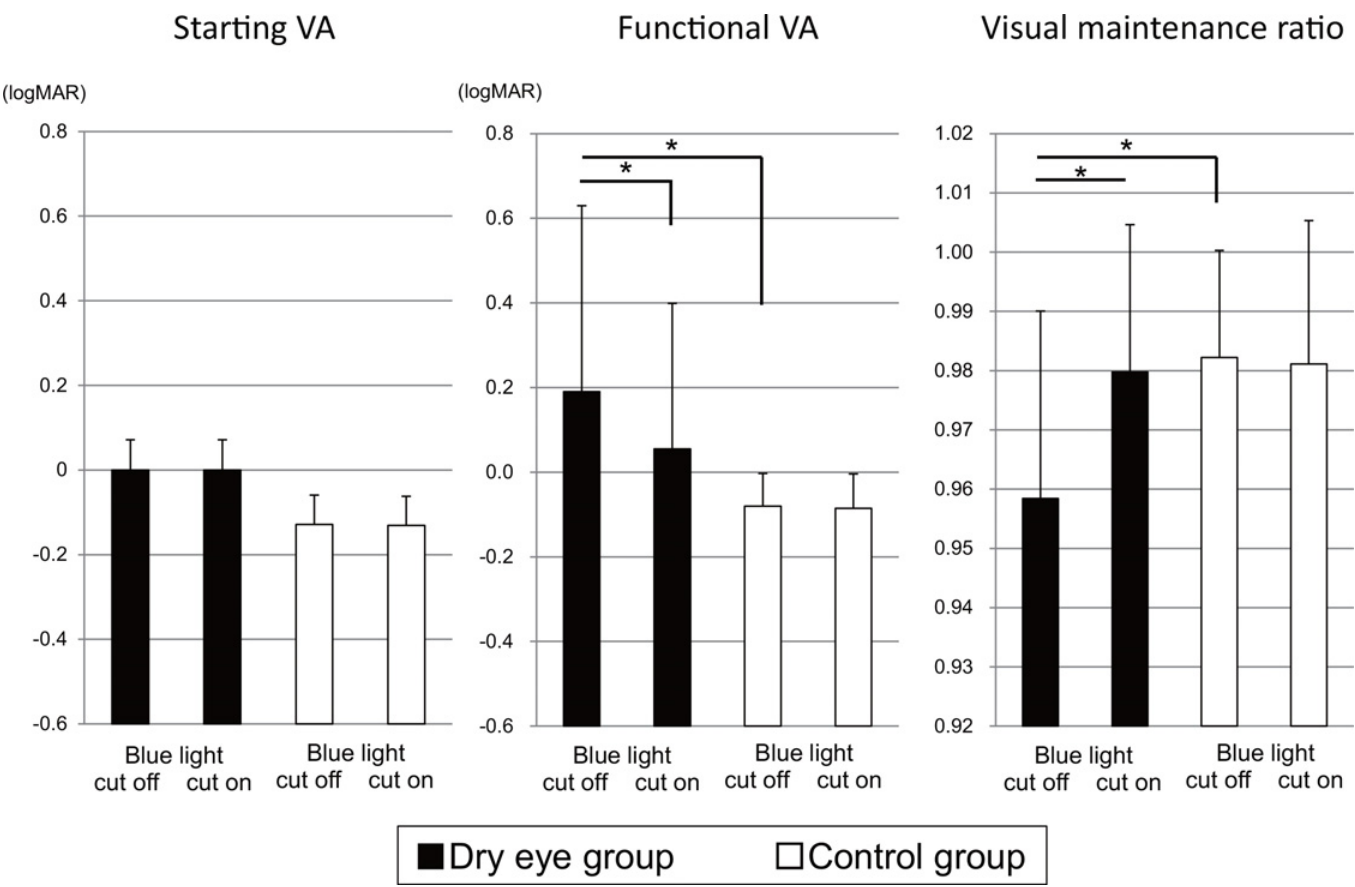
Fig 2. Functional visual acuity (VA) parameters with and without blue light blocked